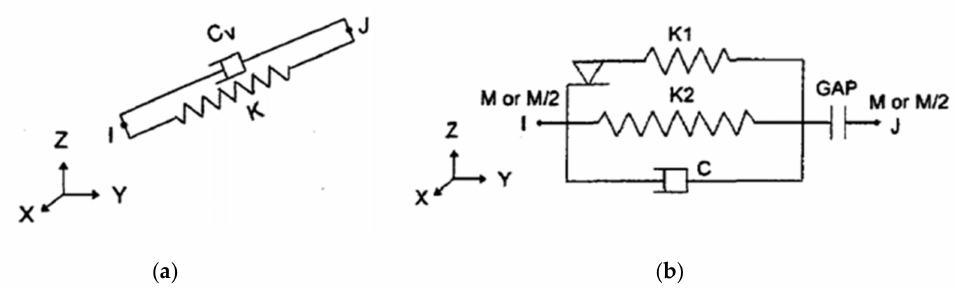
Figure 6. The geometry and mechanical model of the spring-damper element. ( a ) COMBIN14; ( b )